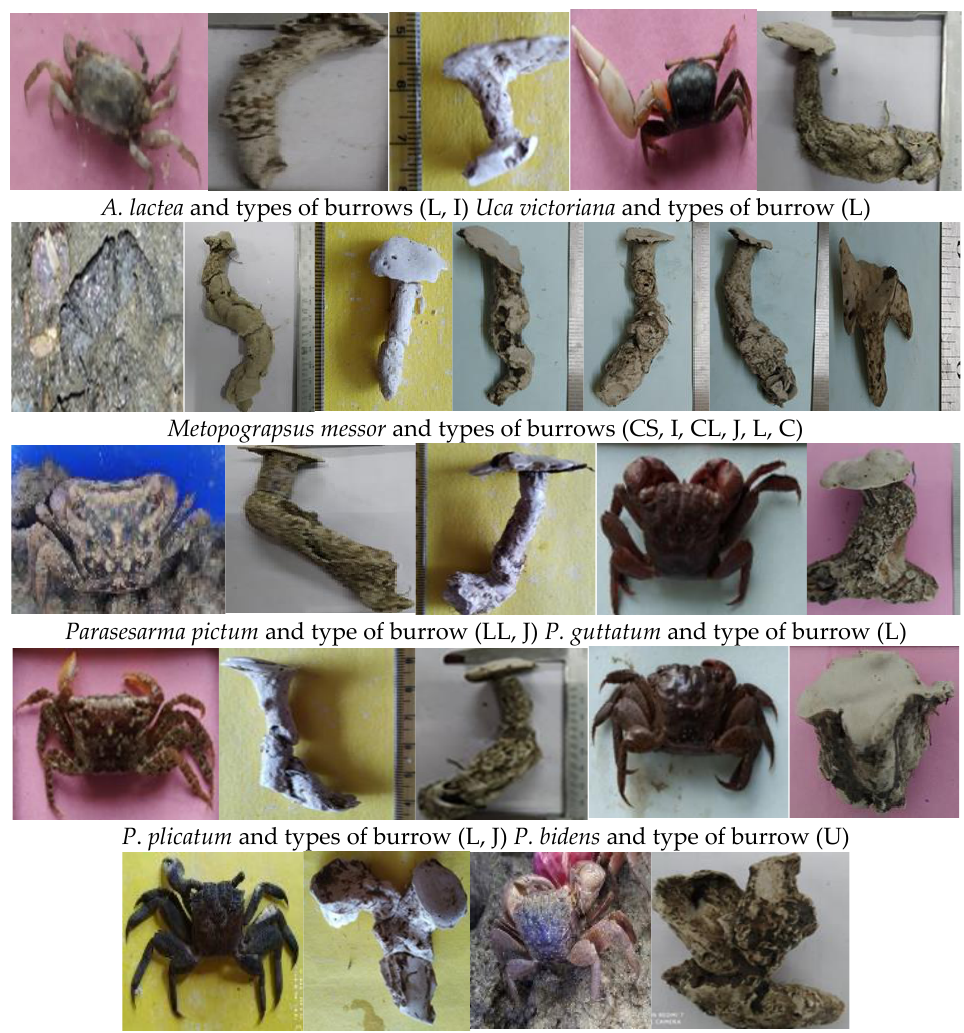
Figure 2. Crab burrow architectures found in restored mangrove habitat.